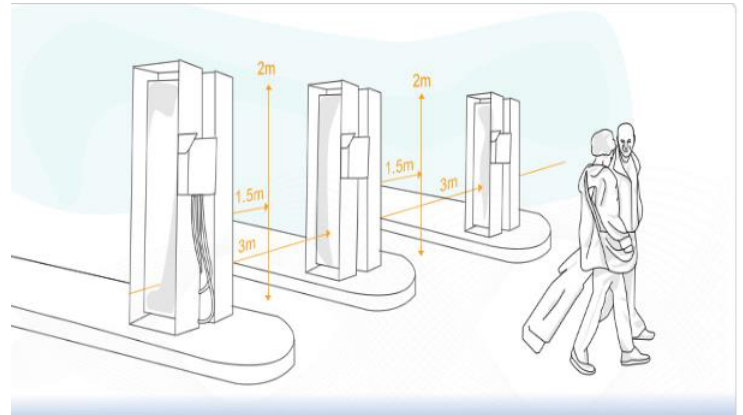
Figure 12. Configuration of pedestrian radiation portal monitor [11] .